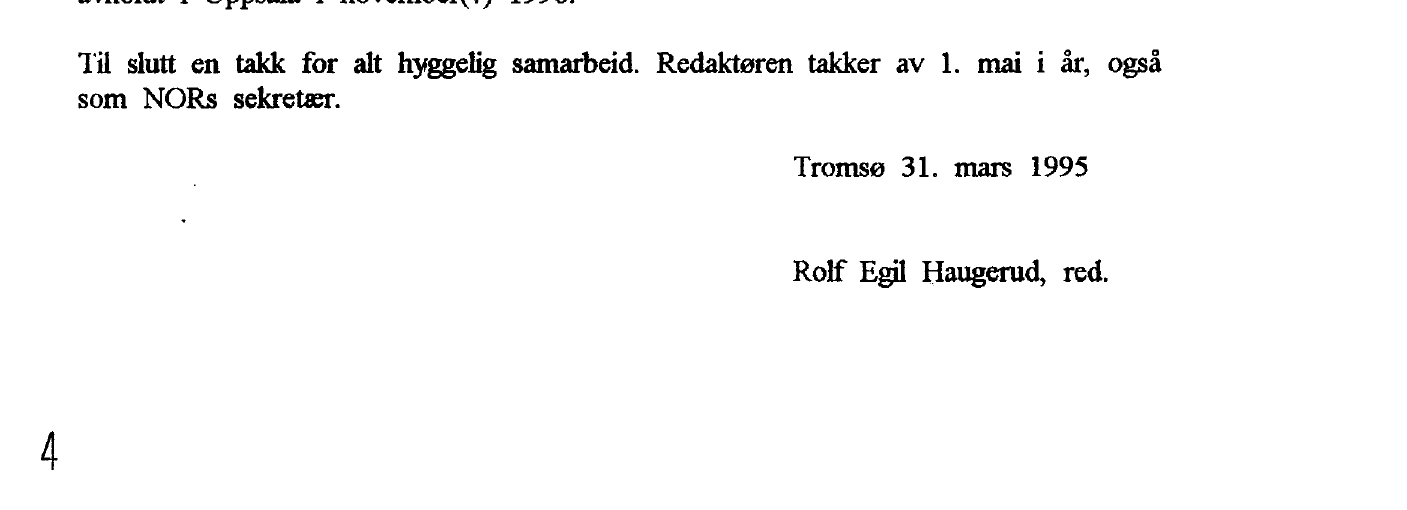
Rolf Egil Haugerud,